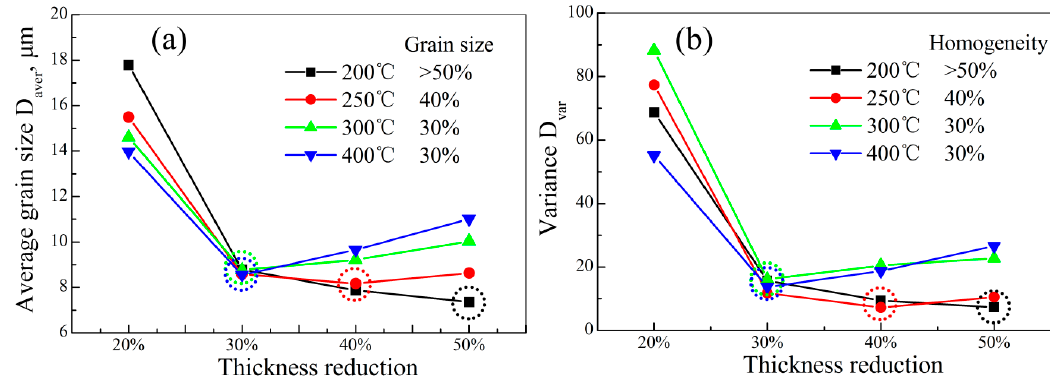
Figure 4. Average grain size variation ( a ) and corresponding variance of microstructure homogeneity of ( b ) AZ31 magnesium alloy sheets under different rolling process parameters.